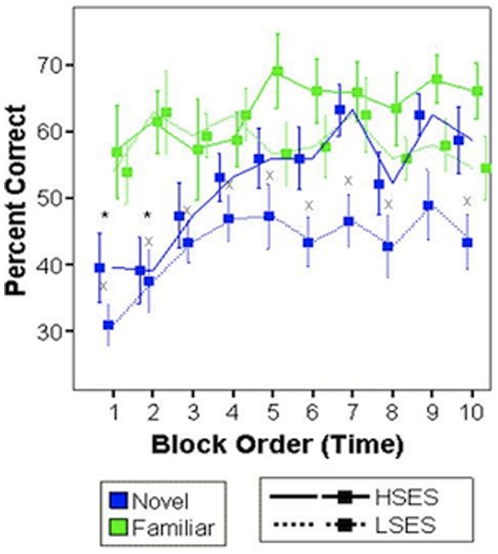
Learning curves for children from high and low SES families for accuracy performance on both Novel (blue) and Familiar (green) rules.Data at each time point is collapsed across instances of Familiar (A/B) and instances of Novel (A/B) rules, yielding 10 time points from an original 20 if instances of rules were viewed separately. HSES children performed significantly less accurately on Novel compared to Familiar rules during early blocks of the scanner task (asterisks) whereas LSES children performed more poorly on the Novel compared to Familiar rule throughout the scan. (*) indicates a significant difference for Familiar Rule Accuracy > Novel Rule Accuracy for HSES participants (solid lines); (x) indicates a significant Familiar Rule Accuracy > Novel Rule Accuracy for LSES participants (dotted lines).